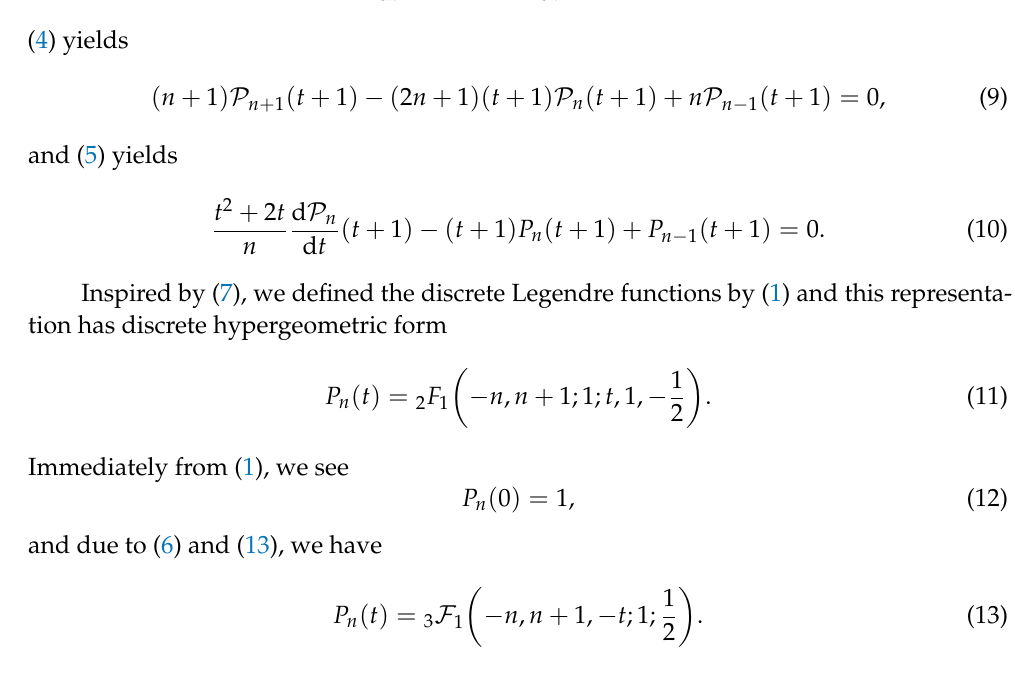
Table 1. The Legendre polynomials P n ( t ) , the shifted Legendre polynomials P n ( t + 1 ) , and the discrete Legendre polynomials P n ( t ) for n ∈ { 0,1,2,3,4 } . The highest-order terms of all of these polynomials actually agree, so there is asymptotic equivalence among all of them in the complex plane as | t | → ∞